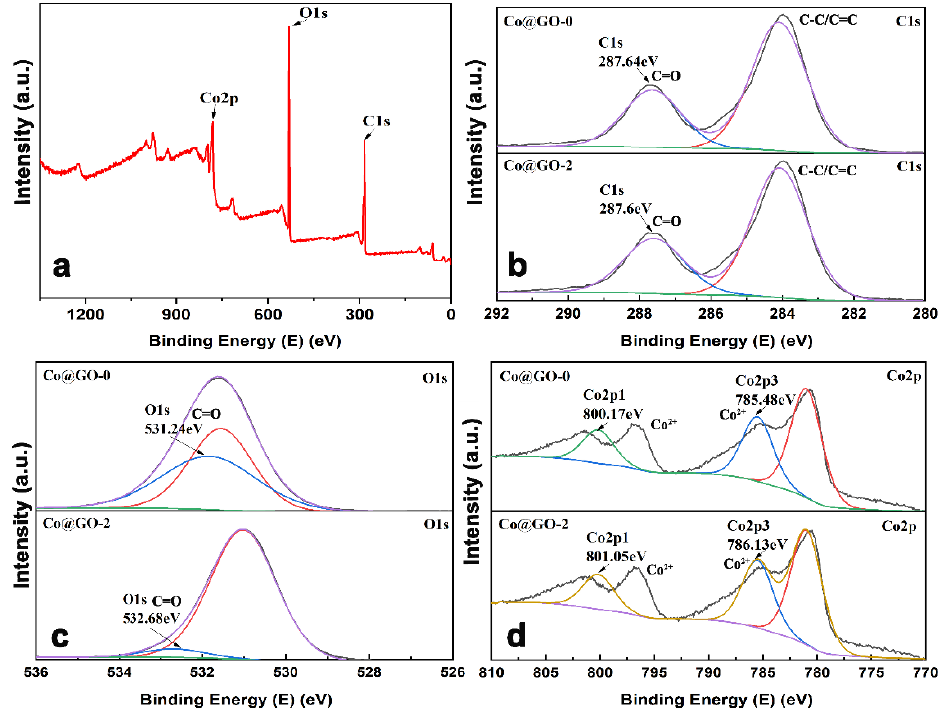
Figure 5. ( a ) XPS survey spectra of Co-BTC and Co-BTC@GO 2, ( b ) C1s, ( c ) O1s, ( d ) Co 2p.